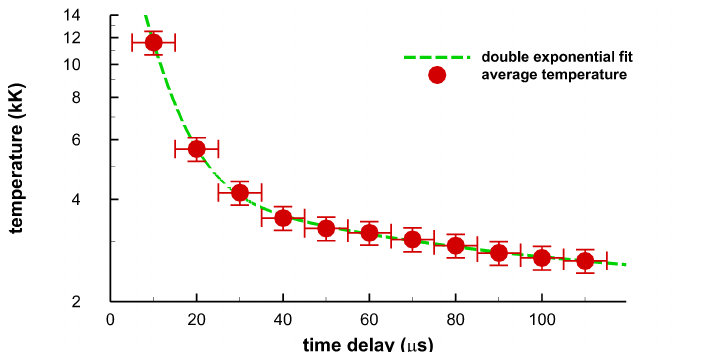
Figure 14. Inferred temperature from spatial averages of the displayed images for 10 µ s to 110 µ s. The dashed line indicates a double exponential fit to the data, see